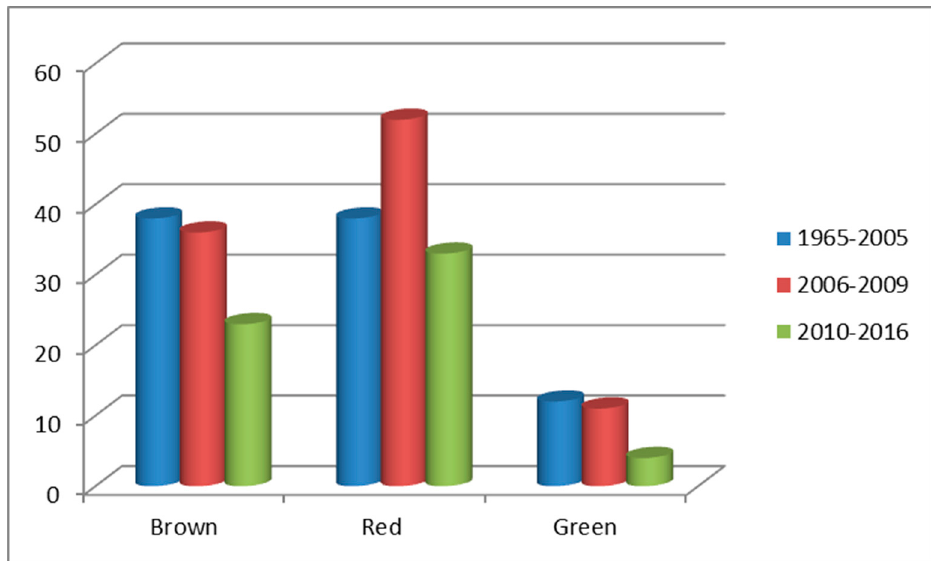
Figure 3. Distribution of the metabolites isolated from macroalgae per year, adapted from Blunt et al. (2009) and completed with data from the same authors [138,139,142–148].